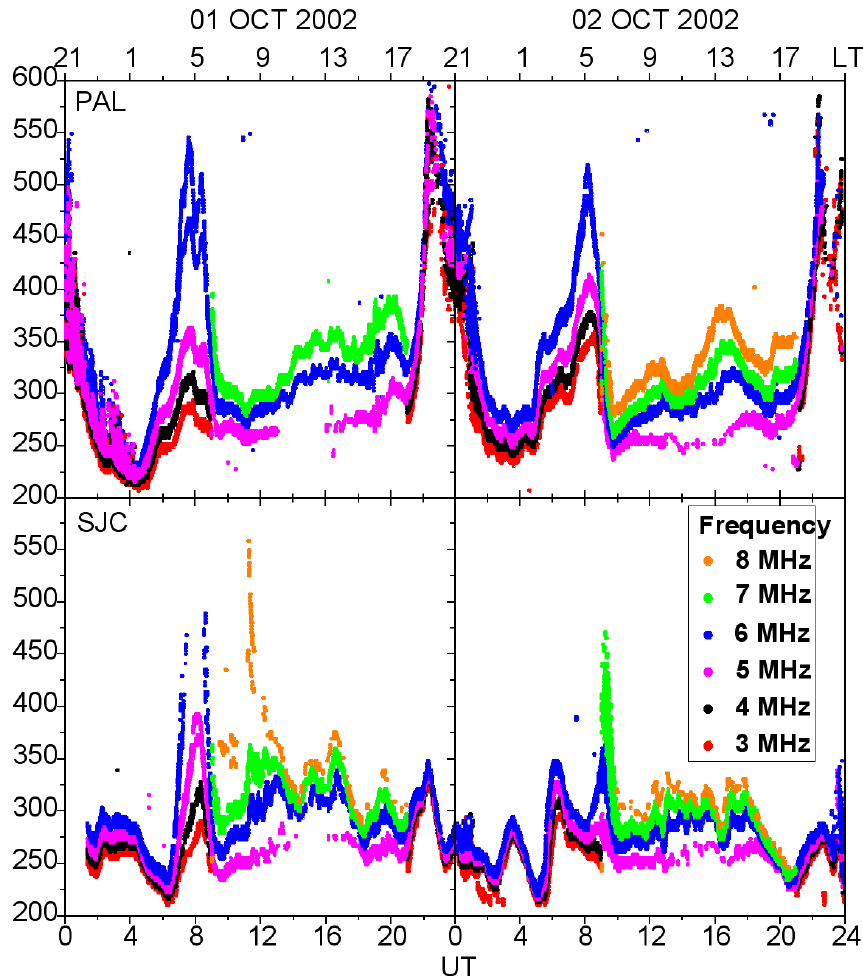
Fig. 1. Virtual height contours as measured in Sao Jose dos Campos and Palmas, Brazil, on 1 and 2 October